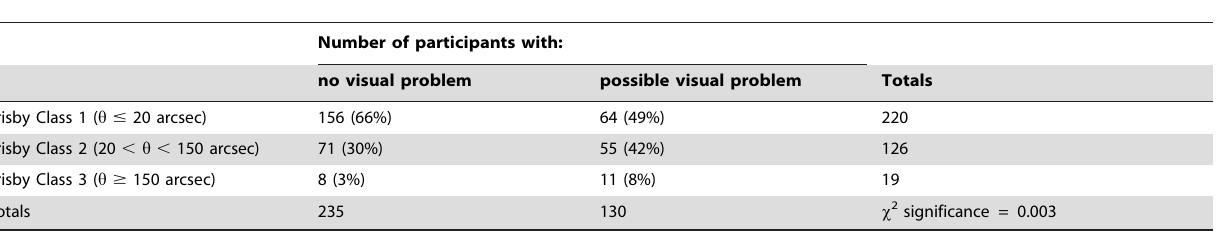
Table 4. Contingency table showing relationship between visual problems and stereo classification on the Frisby test.